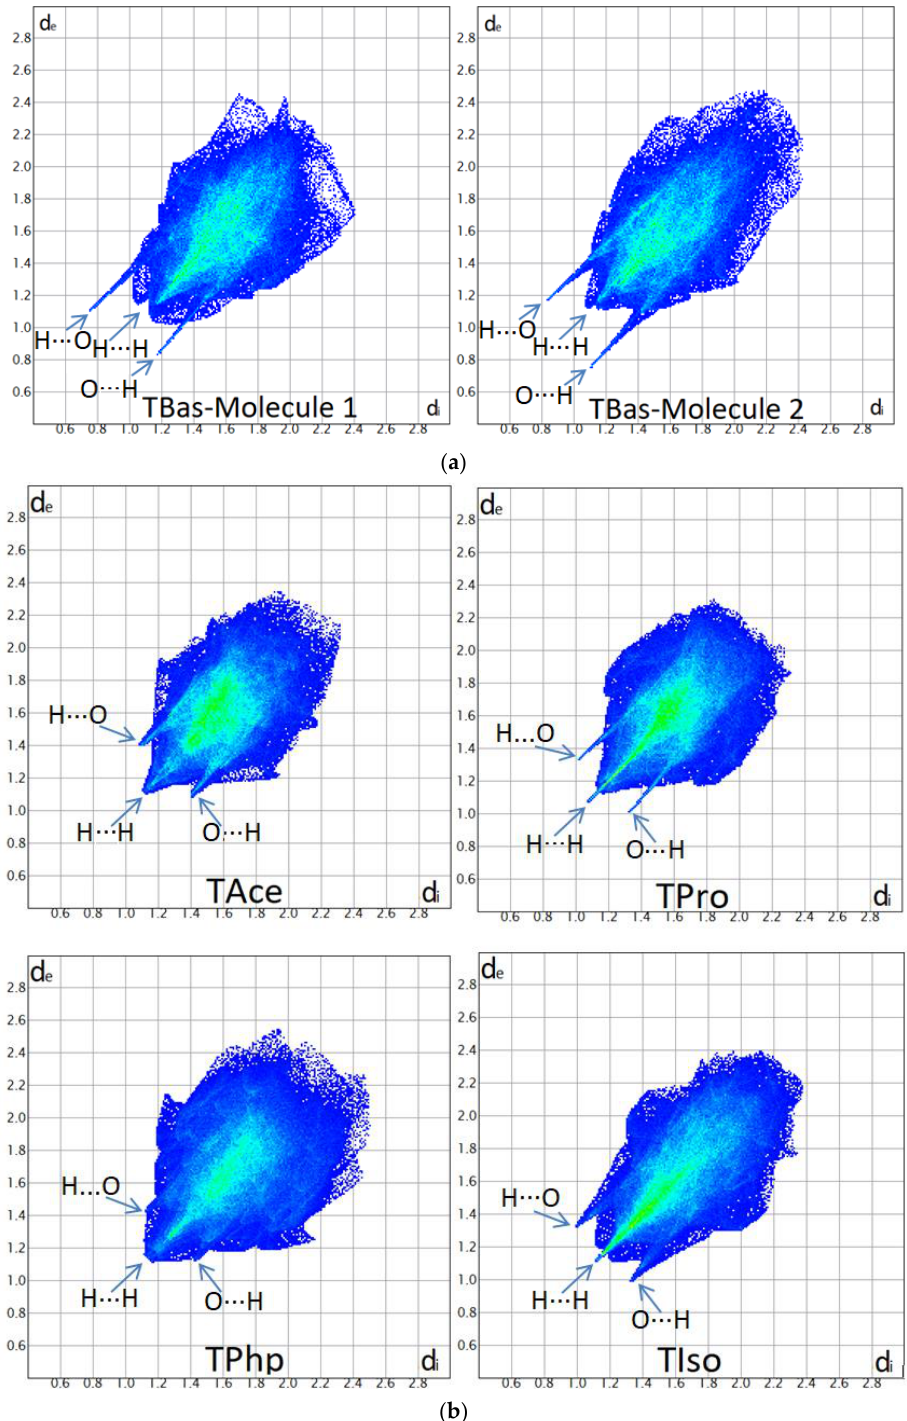
Figure 6 . Fingerprint plots displaying close contacts in studied crystals: TBas ( a ) and studied esters ( b ) . The analyses of 3D Hirshfeld surfaces, their related 2D fingerprint plots shapes, and (d e and d i ) distances summarise the following structural features: